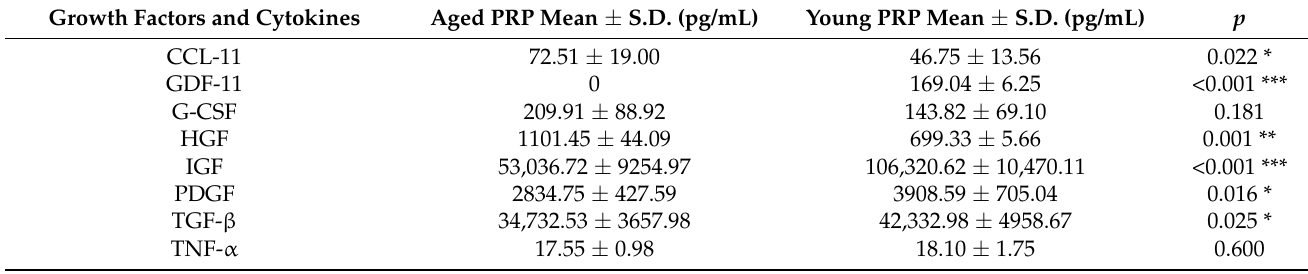
Table 3. Concentrations of growth factors and cytokines in Aged and Young